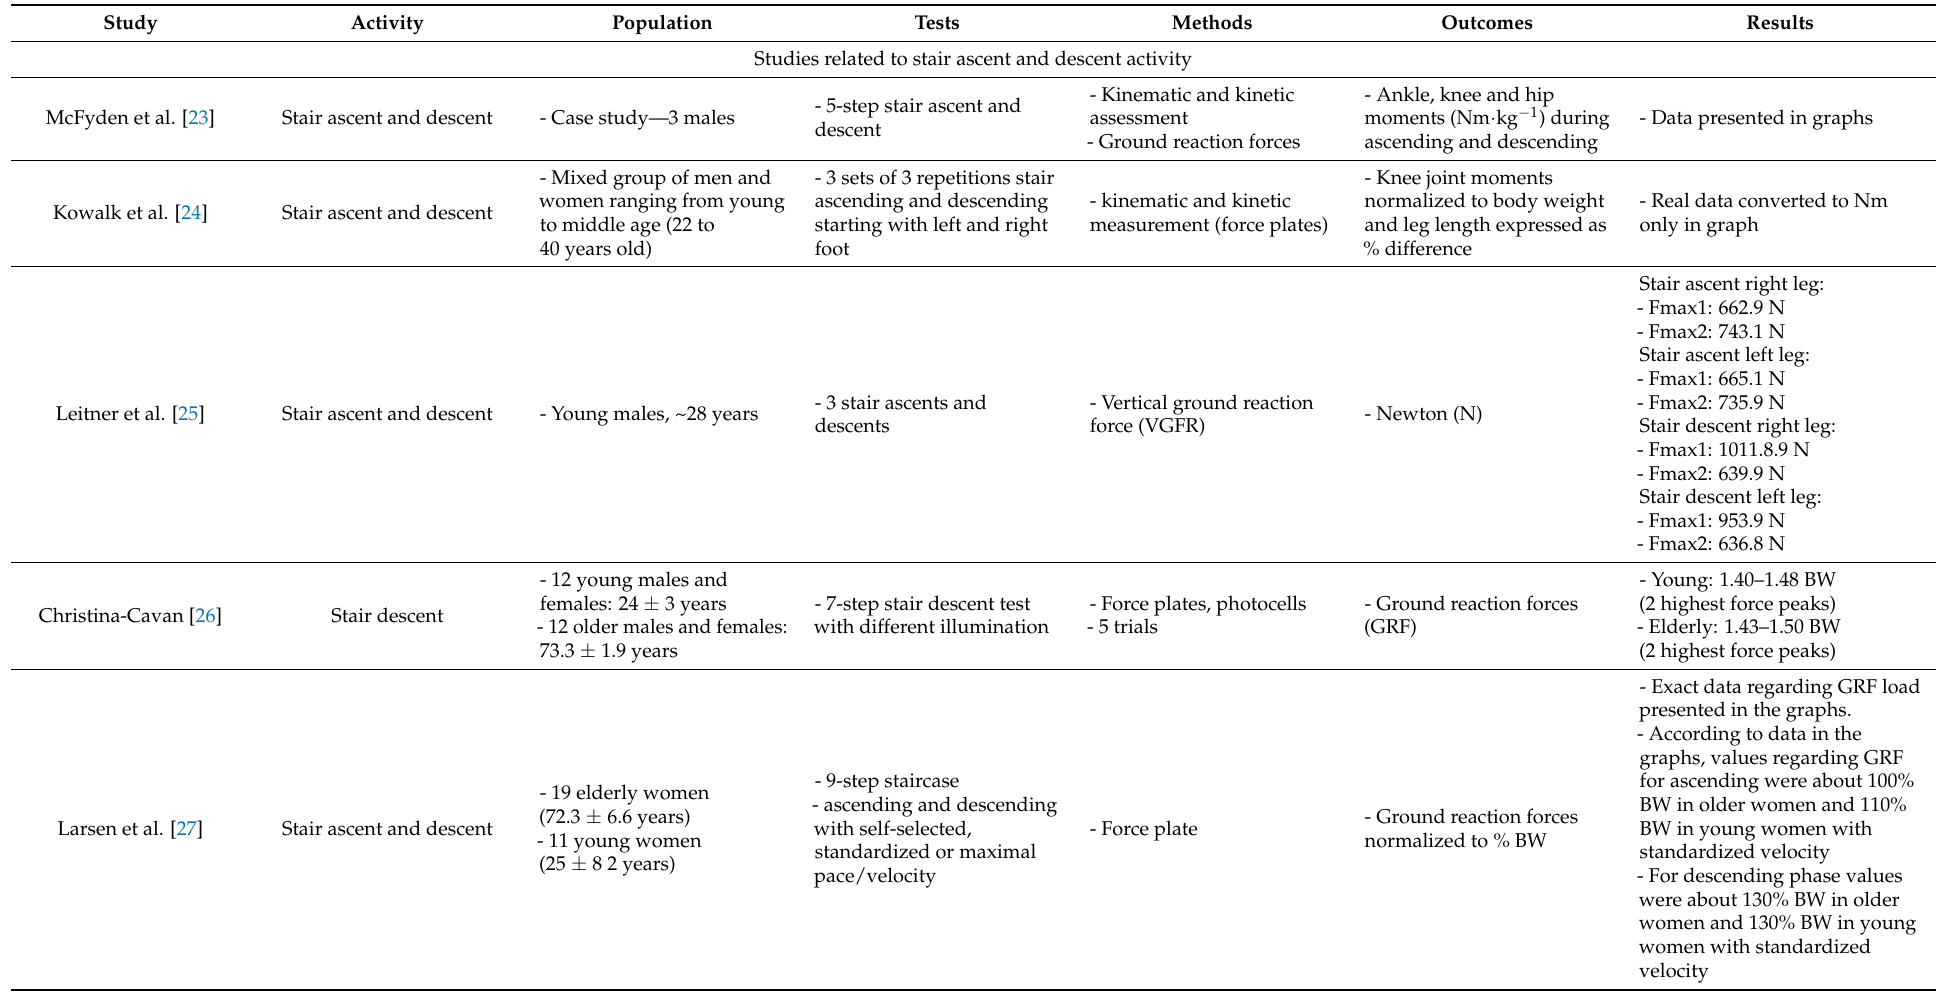
Table 1. Represents summary of studies focused on demands of daily living